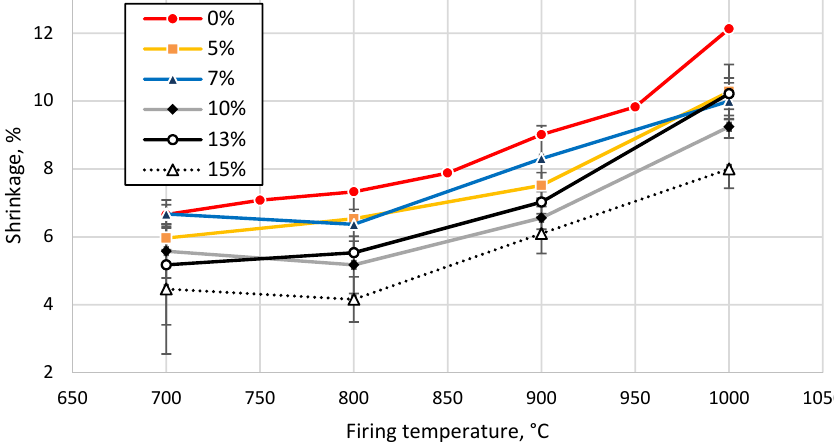
Figure 10. Shrinkage of tested clay-glass ceramic materials after sintering at temperatures from 700 up to 1000 °C. The content of glass in wt% is in the legend. The compressive strength of all tested materials increased with the sintering temperature.